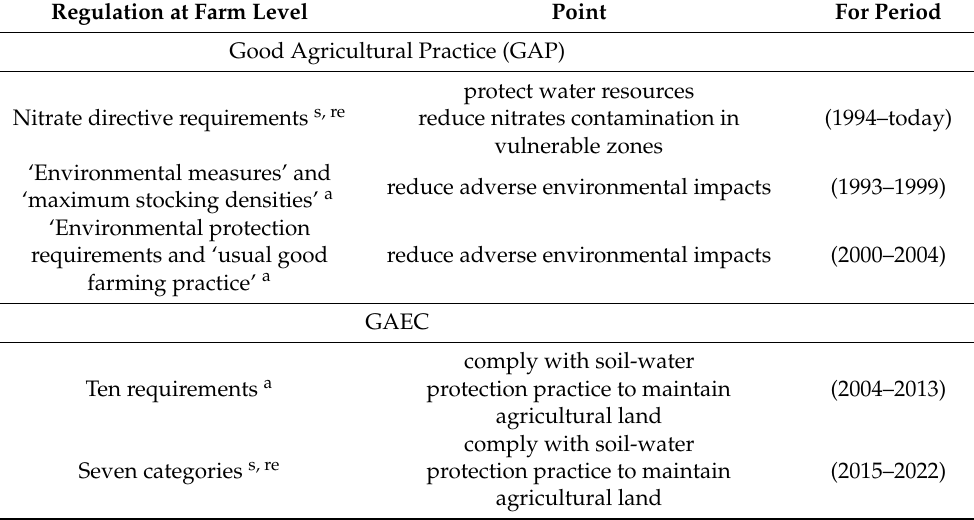
Table 1. Overview of GAEC standards from 1994 to 2022. Regulation at Farm Level Point For